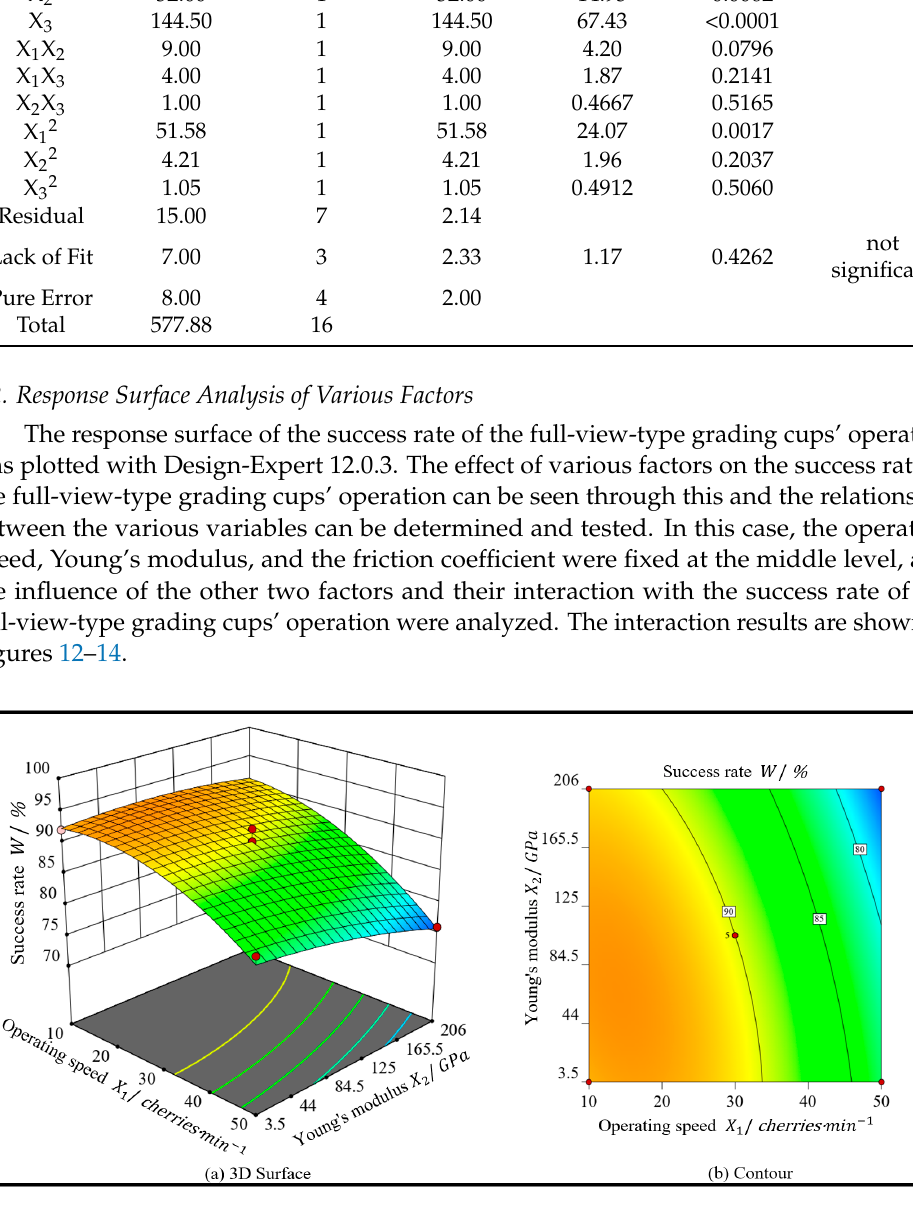
Figure 13. Effects of operating speed and friction coefficient on success rate of sweet cherries.